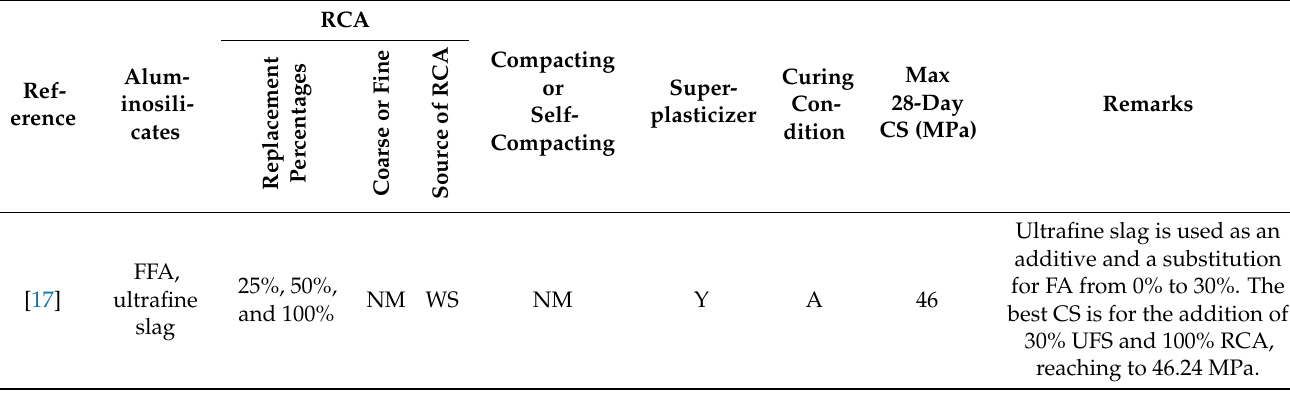
Table A1. Summary of RCA-based GC